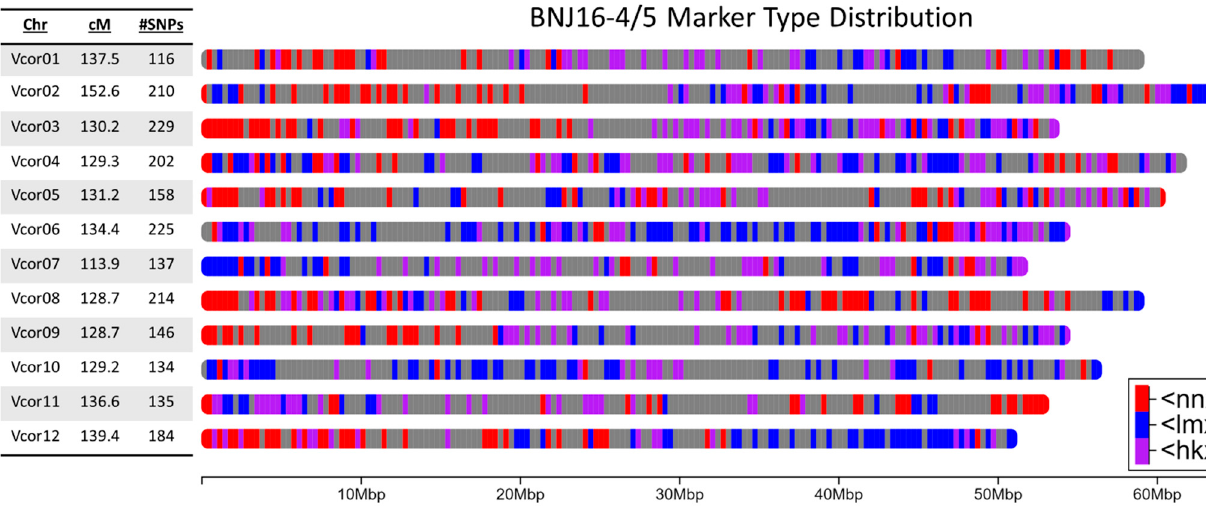
Figure 4. Distribution of markers in the genetic map across the physical chromosomes. <nnxnp> markers are those which are homozygous in BNJ05-237-8 and heterozygous in BNJ05-218-9, <lmxll> are the opposite, and <hkxhk> are heterozygous in both parents.